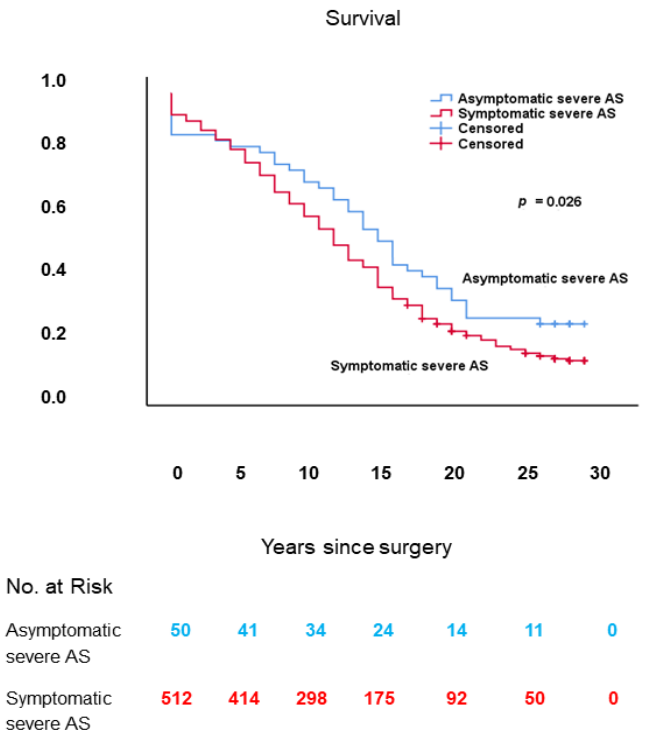
Figure 11. Kaplan–Meier survival curves, from date of surgery, of patients with symptomatic vs. those with asymptomatic severe AS. AS: aortic stenosis.